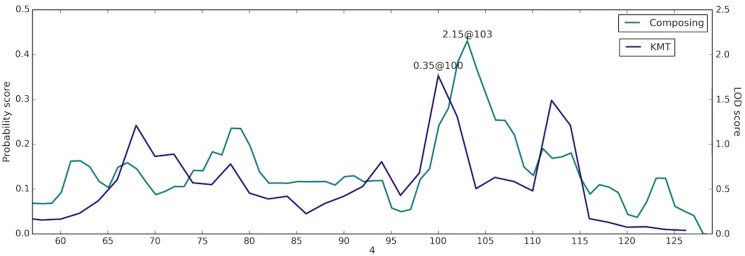
Chromosome 4 linked region overlaps with our previous finding with musical aptitude.Composing is linked to 4q22.1. In a previous article, the same region was found to be linked with KMT scores [35]. The linkage results are shown with solid lines, composing results on the LOD score scale (axis scale on the right) and KMT results as probability scores (scale on the left). The position information is shown in centimorgans.